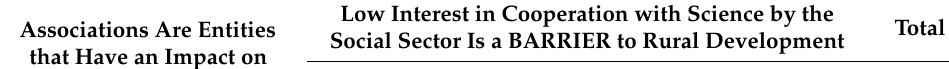
Table 4. Opinion of those recognizing the IMPACT of associations on rural development, on the low interest in cooperation with science by the social sector.